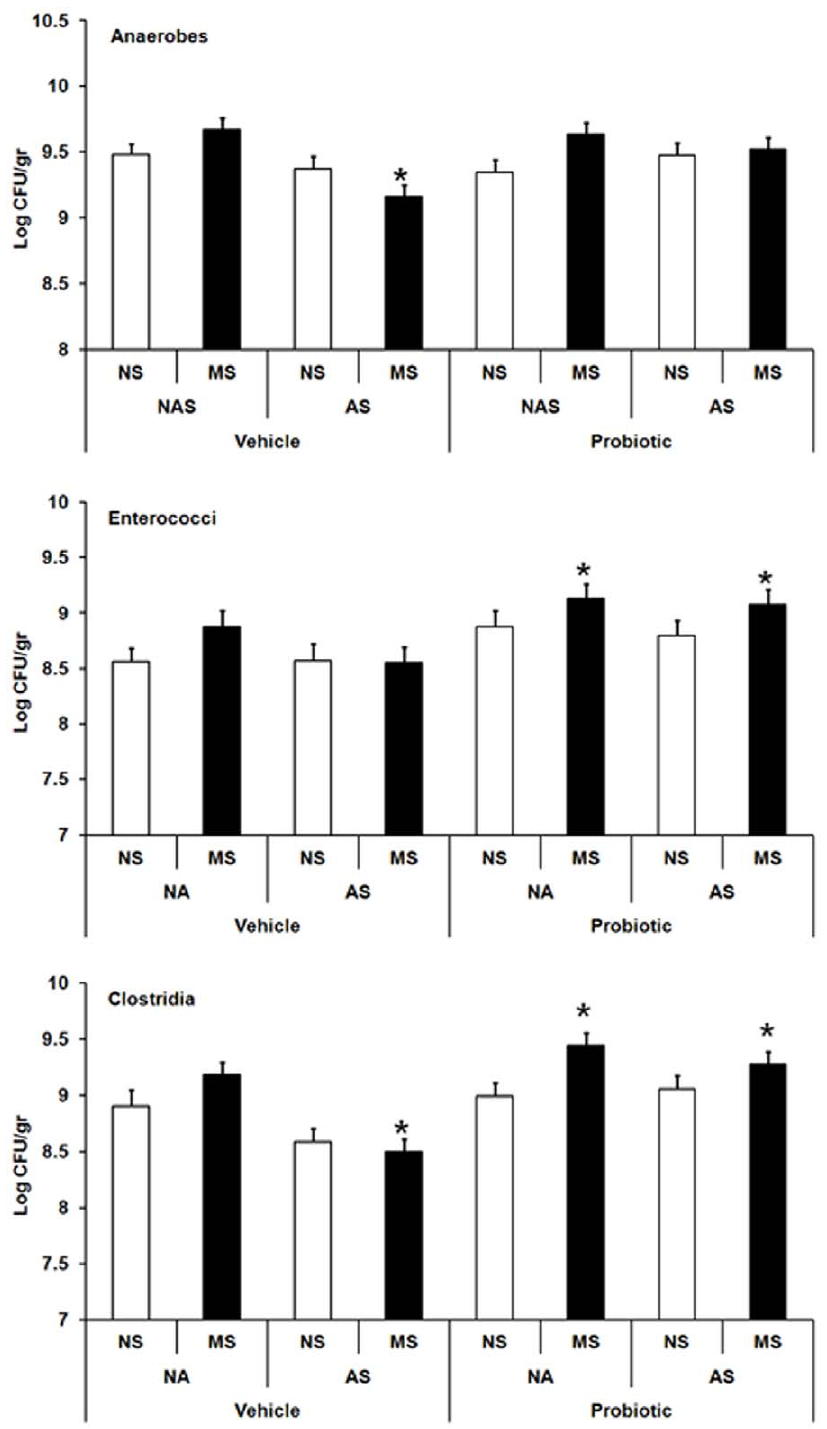
Figure 8. Effect of maternal probiotic intake and stress on adult gut microflora. Effect of maternal probiotic intake, neonatal maternal separation (MS) and adult restraint stress (AS) on faecal counts of anaerobes, enterococci and clostridia (Log CFU/gr, least squares means + SE) in Wistar rats at week 12. Hollow bars represent no-stress control animals or those exposed to adult stress (AS): control vehicle (n=11–19), AS vehicle (n=18–20), control probiotic (n=17), AS probiotic (n=17). Filled bars represent MS or MS + AS animals: MS vehicle (n=20), MS + AS vehicle (n=20), MS probiotic (n=18), MS + AS probiotic (n=19). An asterisk (*) shows significant difference compared to non-stressed (NS-NA) animals in the vehicle subset ( p # 0.05).